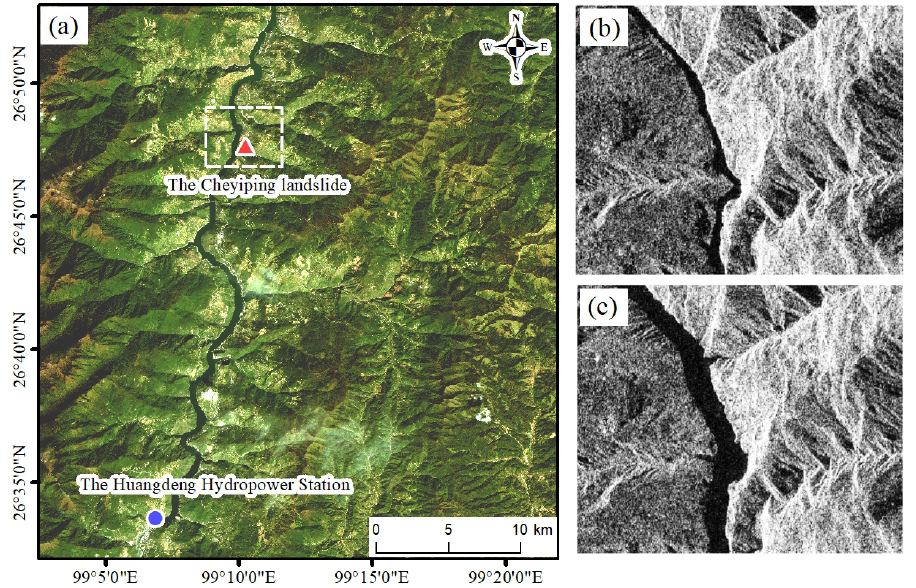
Figure 16. Variation of the Lancang River water level before and after impoundment. ( a ) The relative locations of the Cheyiping landslide and the Huangdeng Hydropower Station. ( b ) SAR image of white dotted line range in ( a ) on 5 January 2018. ( c ) SAR image of white dotted line range in ( a ) on 24 January